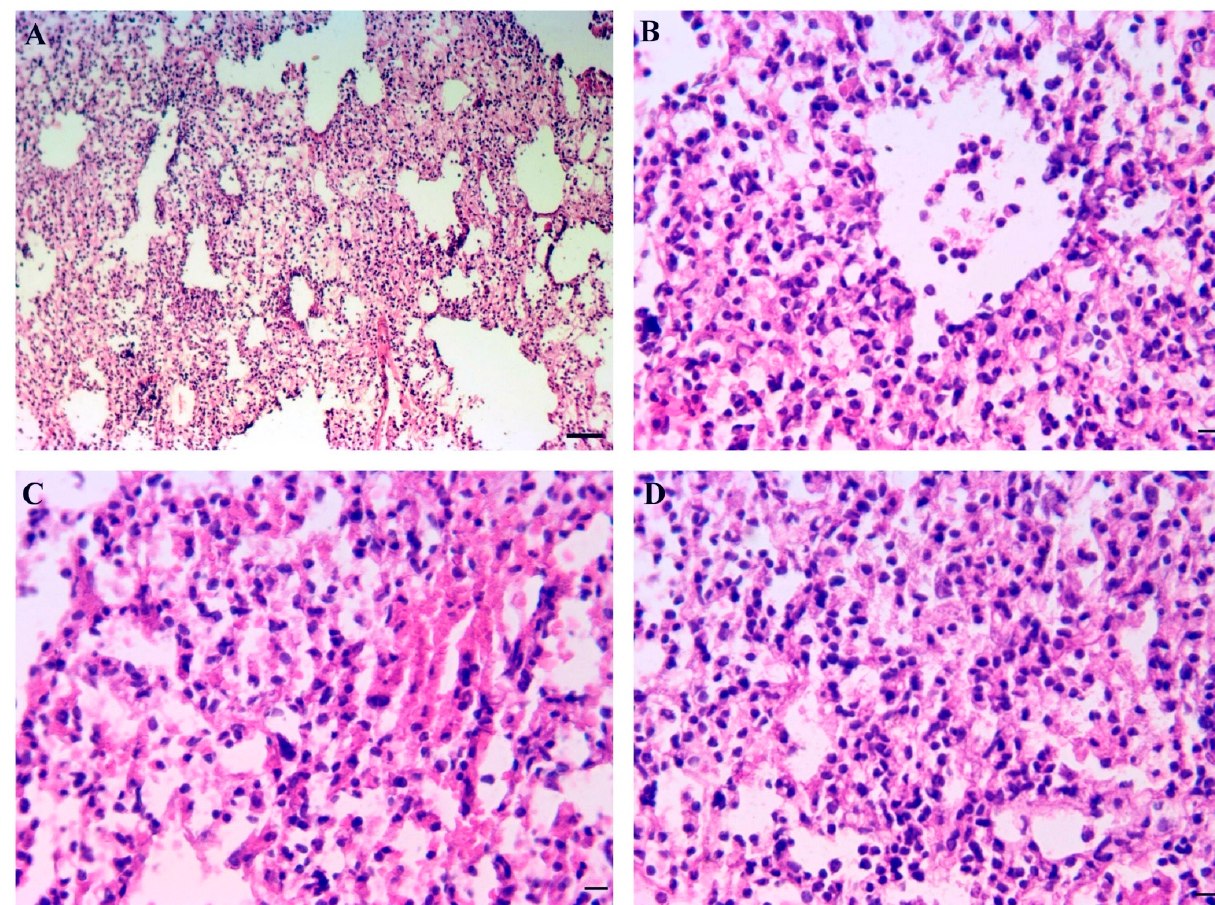
Figure 9. Lung pathology in hamsters after infection by SARS-CoV-2 (Delta strain). ( A ) Diffuse lymphocytic-macrophage infiltrates, acute emphysema with rupture of the interalveolar septa (5 th dpi) HE staining; scale bar 100 µ m. ( B ) Diffuse lymphocytic-macrophage infiltrates, acute emphysema with rupture of the interalveolar septa (5 th dpi) HE staining; scale bar 50 μ m. ( C ) Pronounced hyperemia of the vasculature of the interalveolar septa at 9th dpi HE staining; scale bar 50 μ m. ( D ) Focal hemorrhages are noticeable; in the lumens of some alveoli, cellular infiltrates are found at 9th dpi HE staining; scale bar 50 μ m.